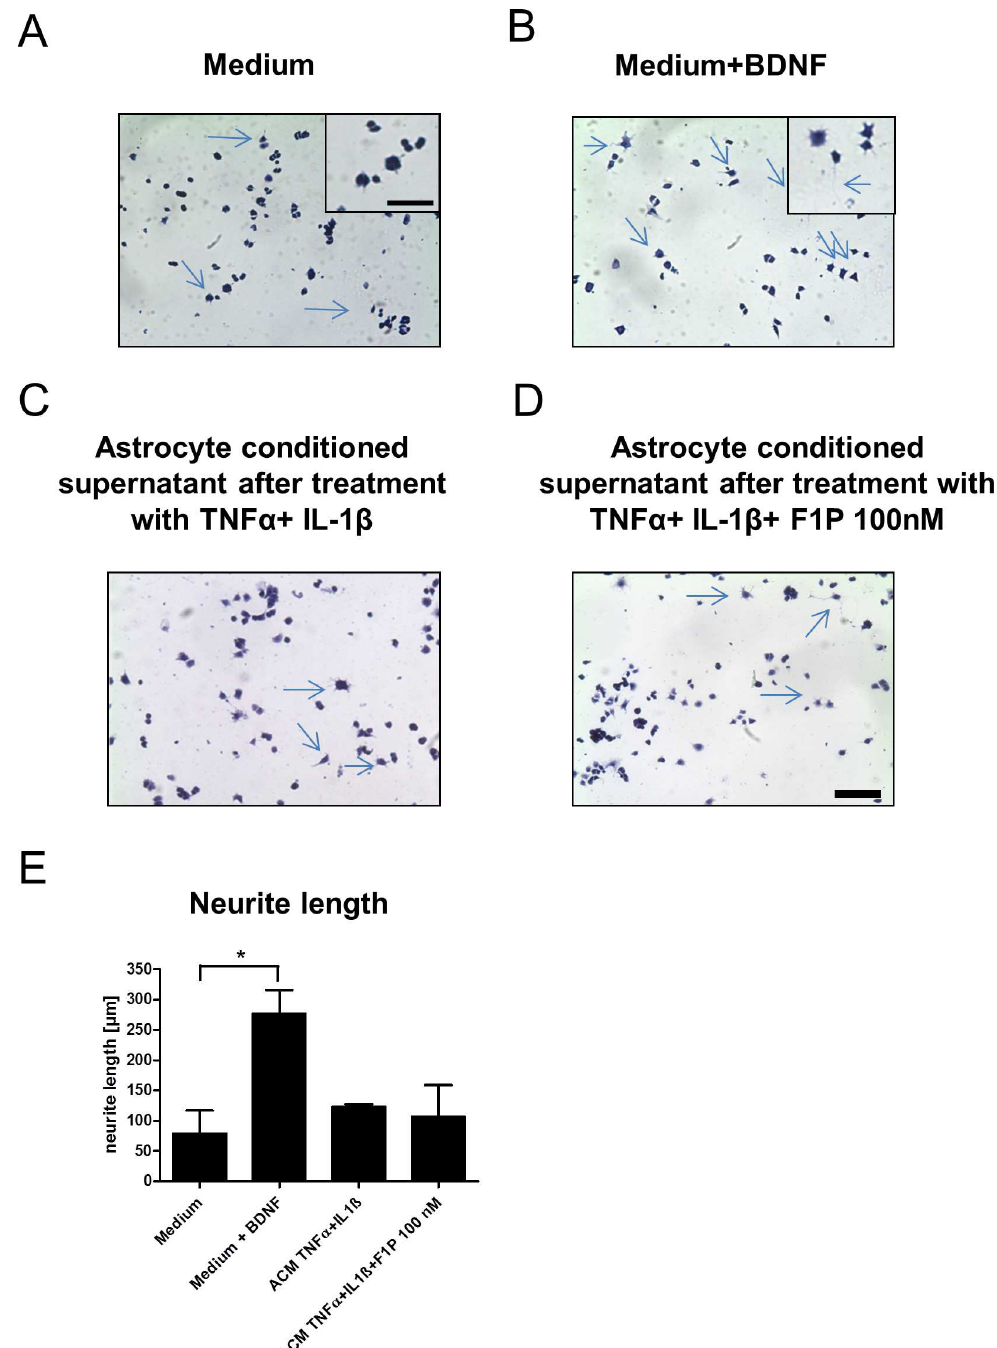
Fig 5. Fingolimod conditioned astrocyte supernatants do not exert growth promoting effectsin PC 12 cells. (A-D) Representative images of PC12 cells in culture after hematoxylineosin staining.Insets in (A) and (B) show highermanigifcation with representativeneurite growth indicatedby arrows. Bar indicates50 µ m in D and 20 µ m in inset. As comparedto (A) medium only as negativecontrol and (B) the additionof BDNF as positive control, the additionof conditioned supernatnats from IL-1 β and TNF α inflamedastrocytes with or without F1P treatment at 100 nM (C,D) did not lead to increasedneurite lenght. (E) Blindedquantification of neurite lenghtsin PC 12 cell culture. ACM, astrocyte conditionedsupernatant. Data are given as mean ± SEM, n = 3 per group, 1 out of 2 experiments is shown. * p < 0.05 for medium versus addition of BDNF as positive control, Kruskal Wallis test.